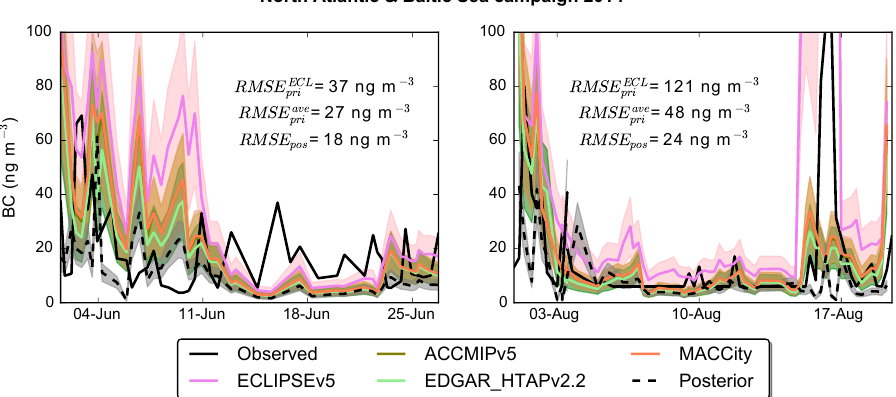
Figure 8. Comparison of prior (ECLIPSEv5, ACCMIPv5, EDGAR HTAPv2.2 and MACCity) and posterior simulated concentrations of BC with observations from a ship campaign in North Atlantic and Baltic Seas in 2014 adopted from Shevchenko et al. (2016). The variability of the prior concentrations (shaded area) was calculated as the standard deviation of BC concentrations from the 12 species with different scavenging coefficients as shown in Table 2. Uncertainties of the posterior concentrations are due to scavenging and use of four different a priori datasets (Sect. 3.4). RMSE values are computed for ECLIPSEv5 concentrations, all prior concentrations (average) and posterior simulated BC